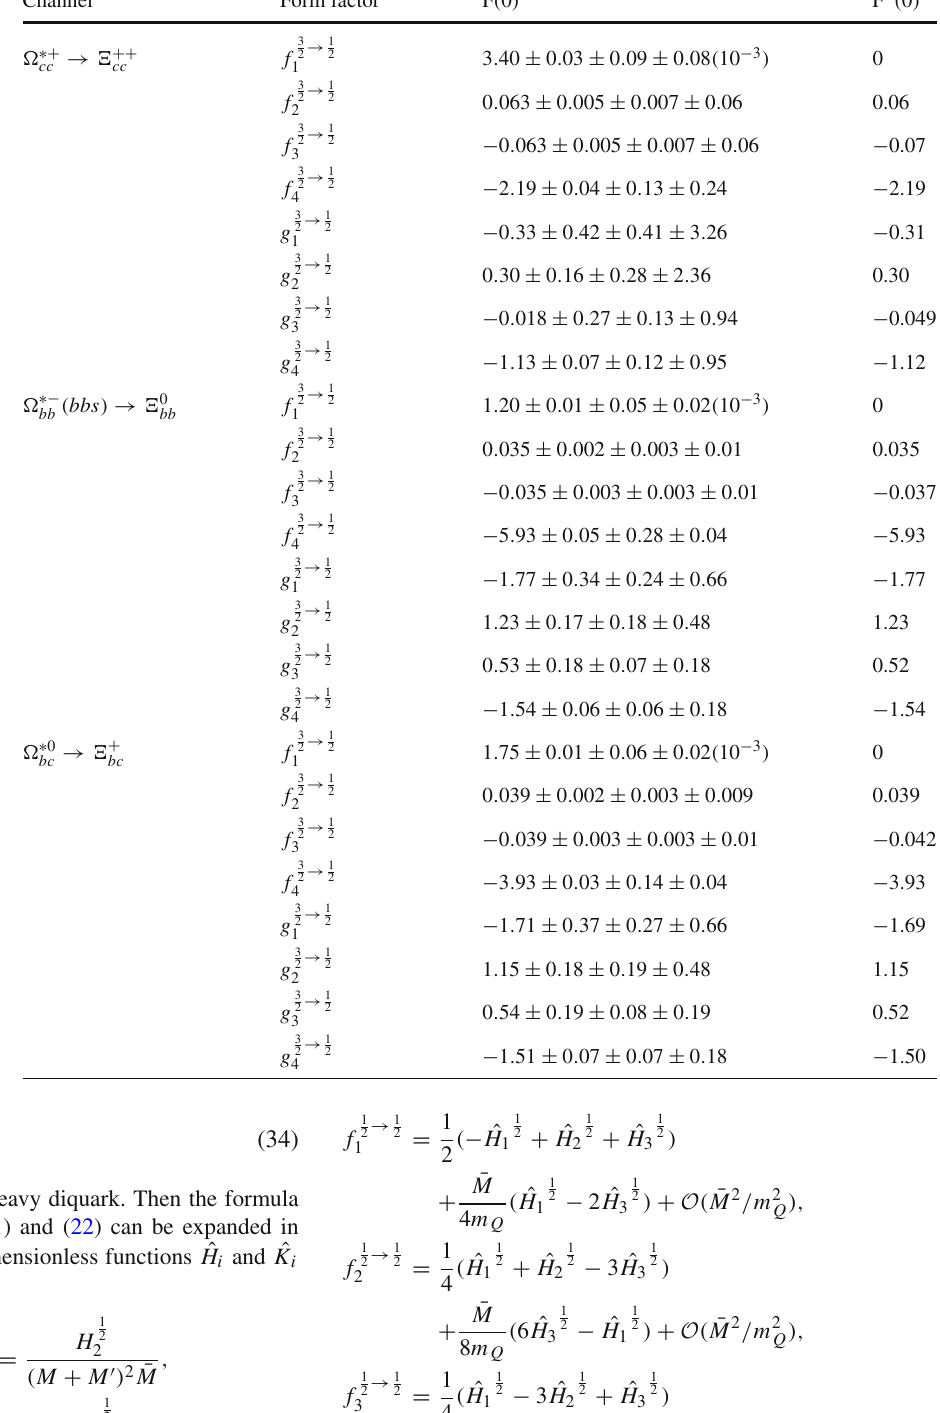
the form factors in spin-3/2 to spin-1/2 doubly heavy baryon decays induced by s → u . The F ∗ ( 0 ) indicates the form factors simplified in the heavy quark limit in Eq.